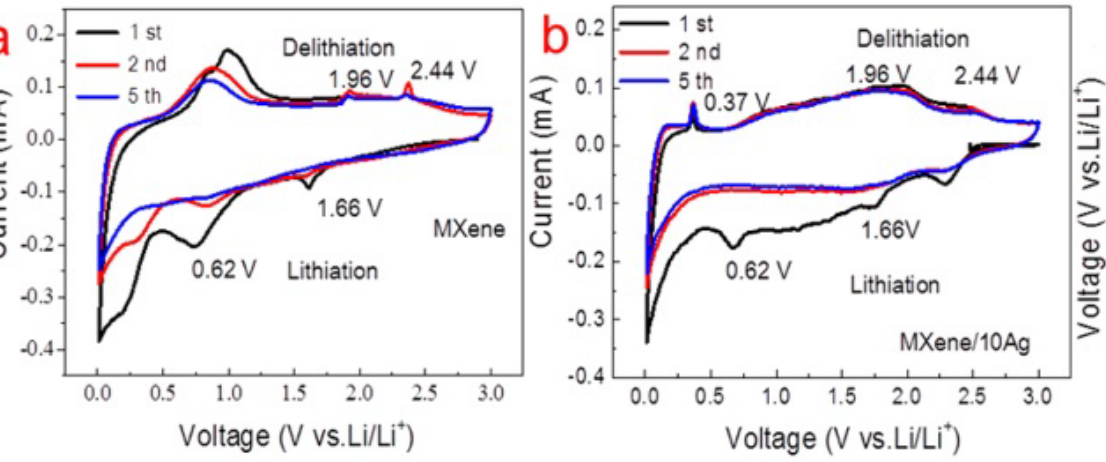
Figure 40. Cyclic voltammetry curves of the MXene ( a ) and MXene/10g ( b ) samples at the initial 5 cycles. Reprinted with permission from [78]. Copyright 2016 American Chemical Society.